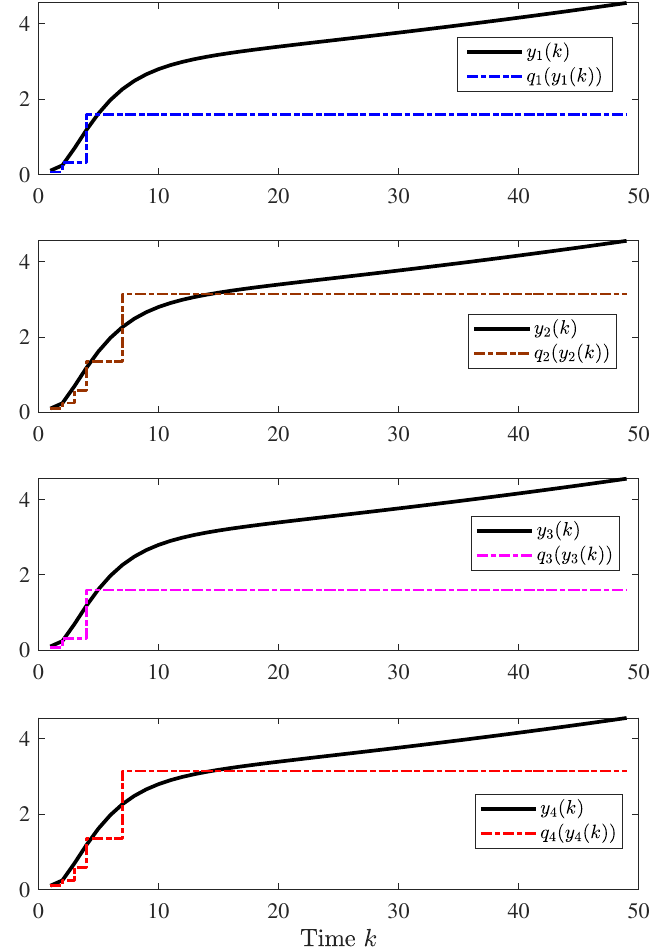
Figure 10. The actual measurement y ( k ) , and the quantified measurement q i ( y i ( k )) , i =